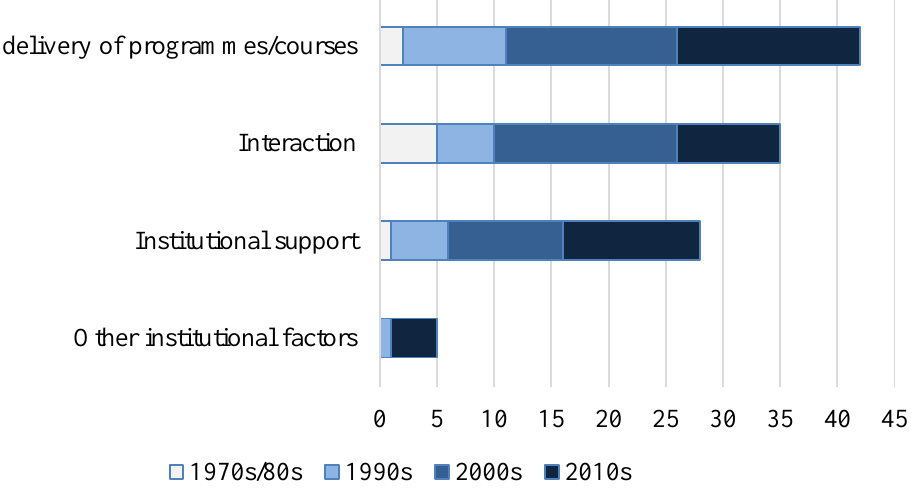
Figure 6. Frequency count of the subcategories of institutional factors in various periods. The environmental factors (Figure 7) related to work are the most frequent. It is worth noting that this subcategory was studied most in the 1990s and 2000s, while in the 2010s relatively fewer new factors were identified. Also, many of the environmental factors became diverse and could not be categorised into family or work factors as shown in Figure 4, and therefore there is a large subcategory of other environmental